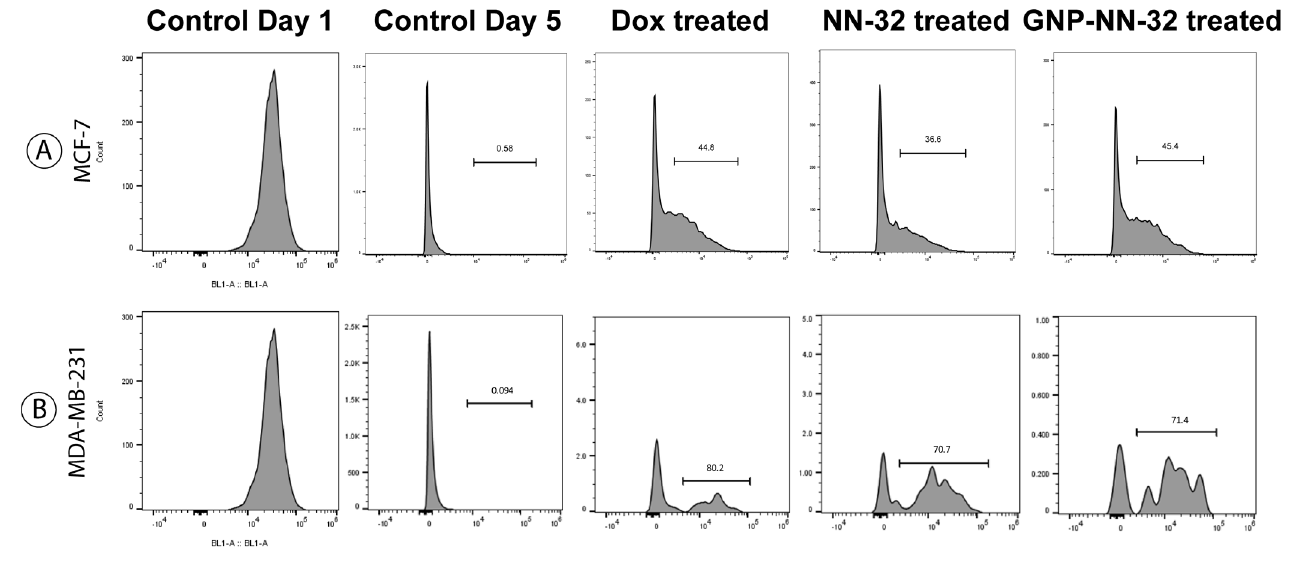
Figure 9. Cell proliferation study of human breast cancer cells stained with CFSE, after treatment with doxorubicin, NN-32 and GNP-NN-32. (A) MCF-7 cells and (B) MDA-MB-231 cells.